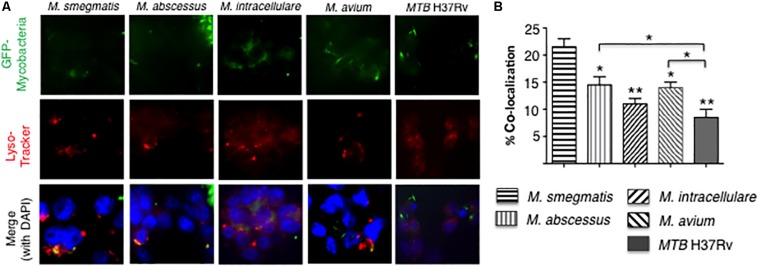
More virulent mycobacteria induced less phagosome–lysosome fusion in macrophages. (A) Localization of phagosome–lysosome fusion in human THP-1 macrophages following infection with GFP-labeled mycobacteria for 6 h. Shown are representative fluorescent photomicrographs of three independent experiments. (B) Quantification of the percentage of THP-1 cells with co-localization of GFP-labeled mycobacteria and lysosomes. Data shown are the mean ± SEM of three independent experiments. Unless otherwise indicated, the individual *p < 0.05 and **p < 0.01 are compared to M. smegmatis-infected cells. Multiplicity-of-infection of 10 mycobacteria:1 macrophage.